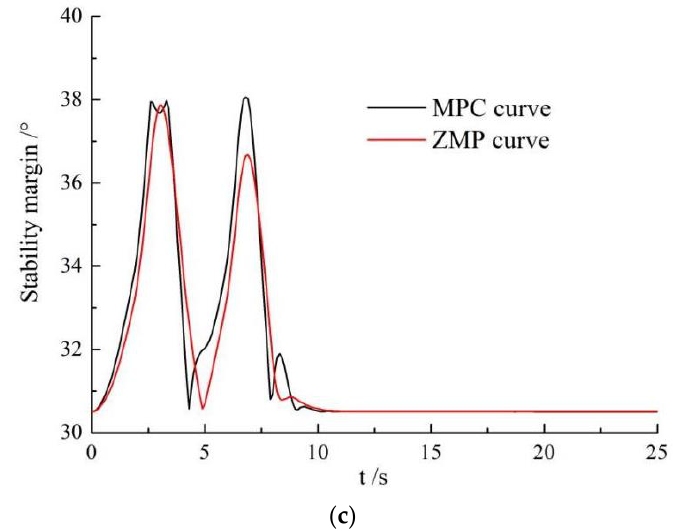
Figure 13. Comparison diagram of state quantity and reference quantity. ( a ) trajectory, ( b ) yaw angle, and ( c ) stability margin.